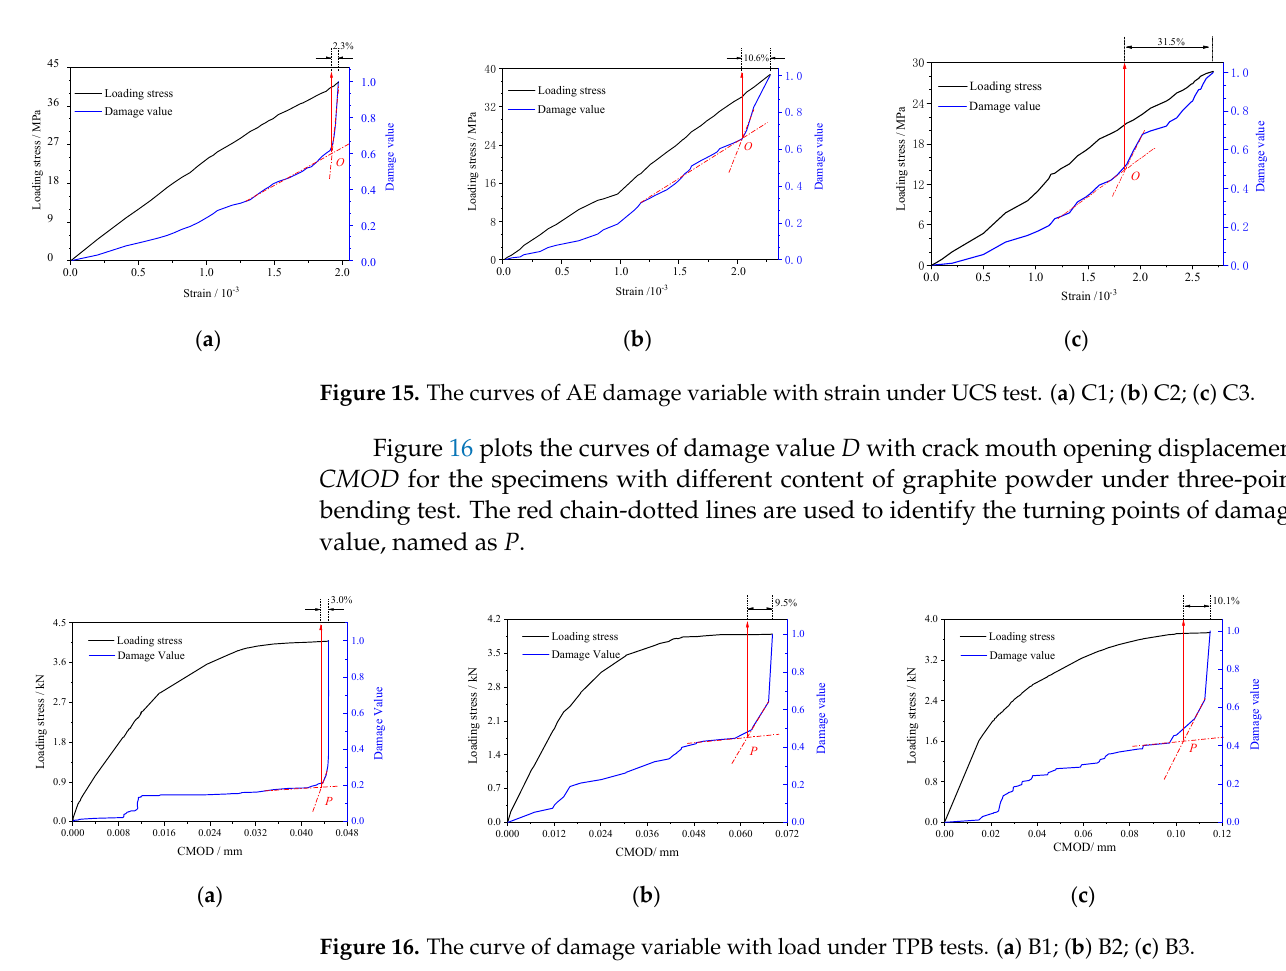
Figure 15 plots the curves of damage value D with strain ε for the specimens with different graphite powder content under the compression test. The red chain-dotted lines relationship, so that the damage form is changed from a brittle fracture to ductile fracture, are used to identify the turning points of damage value, named as O . and the failure of concrete under compression is more predictable. Figure 15. The curves of AE damage variable with strain under UCS test. ( a ) C1; ( b ) C2; ( c ) C3.